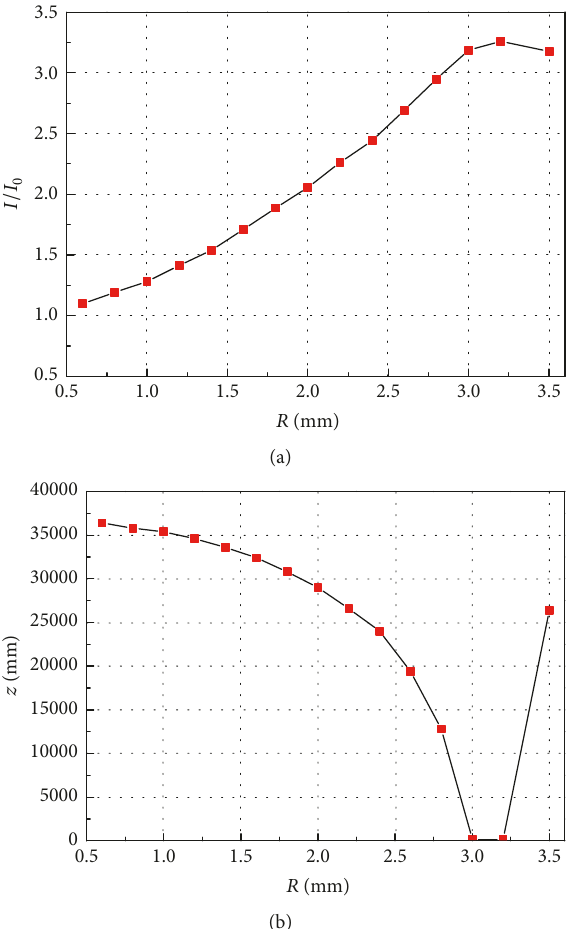
Figure 6: Maximum intensification factor and corresponding location varying with defect size along downstream light field: (a) maximum intensification factor and (b) corresponding